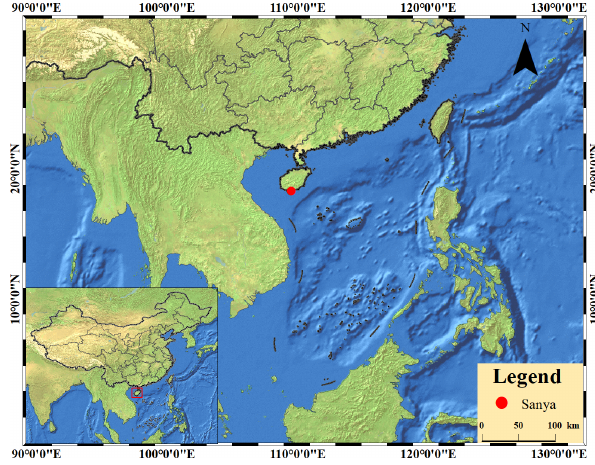
Figure 1. Map showing the Sanya sampling site and surrounding areas. The map was drawn using ArcGIS software. The base map is the World Topographic Map from © ESRI (Environmental Sys- tems Research Institute, Inc.) (http://www.arcgis.com/home/item. html?id=30e5fe3149c34df1ba922e6f5bbf808f, last access: